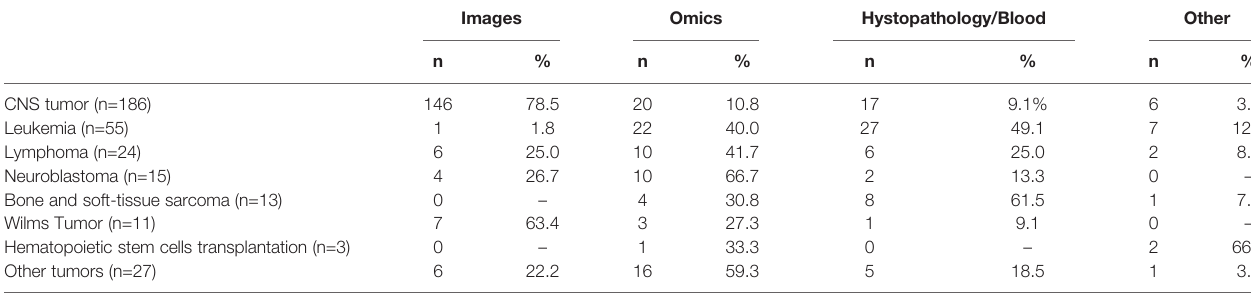
TABLE 3 | Distribution of diagnosis and source of information for the AI application in publications selected for the bibliometric analysis. Images Omics Hystopathology/Blood Other n % CNS tumor